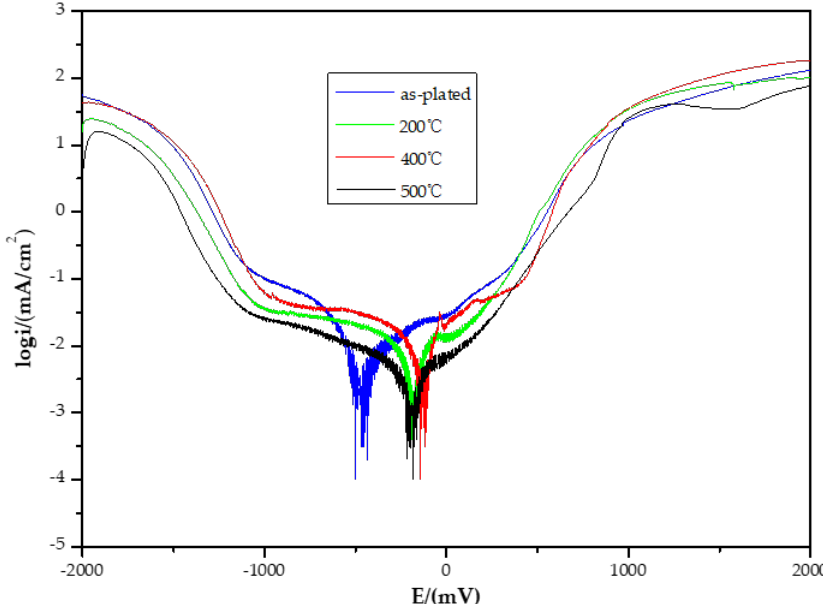
Figure 3. Polarization curves of Ni-P coatings with heat treatments at different temperatures.